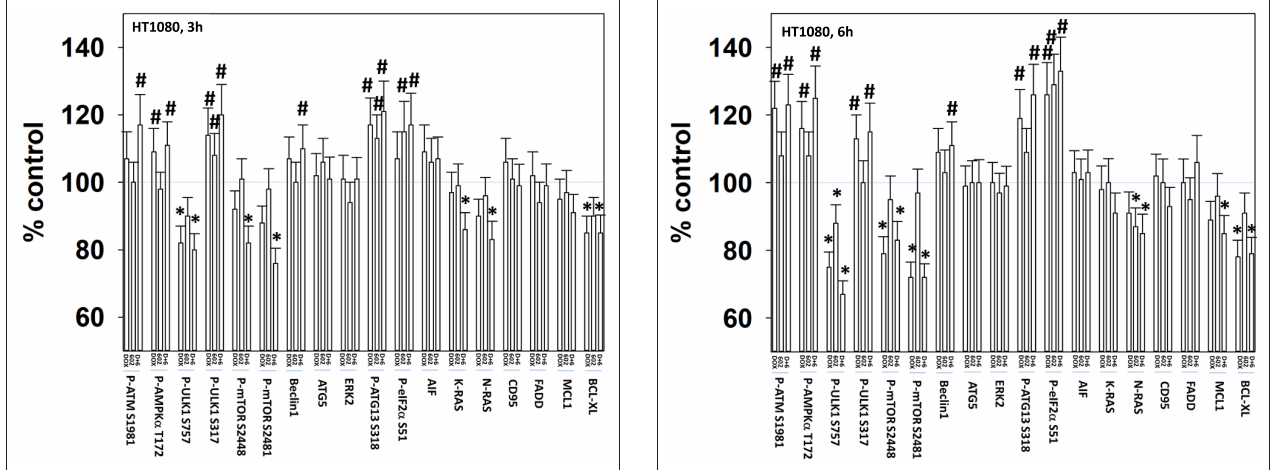
FIGURE 3 | GZ17-6.02 and doxorubicin interact after a 6h exposure to activate an ATM-AMPK-ULK1- autophagy pathway concomitant with inactivation of mTOR and increased Beclin1 expression. HT1080 human sarcoma cells were treated with vehicle control, GZ17-6.02 (2 µ M final curcumin), doxorubicin (200nM) or the drugs in combination for 3 and 6h. Cells were fixed in place and immunostained to detect the total expression and the total phosphorylation of the indicated proteins. The phosphorylation of each phosphoprotein was corrected for total protein expression; non-phosphoproteins had their expression corrected using invariant ERK2 expression. ( n = 3 + /–SD) * p < 0.05 less than vehicle control; # p < 0.05 greater than vehicle